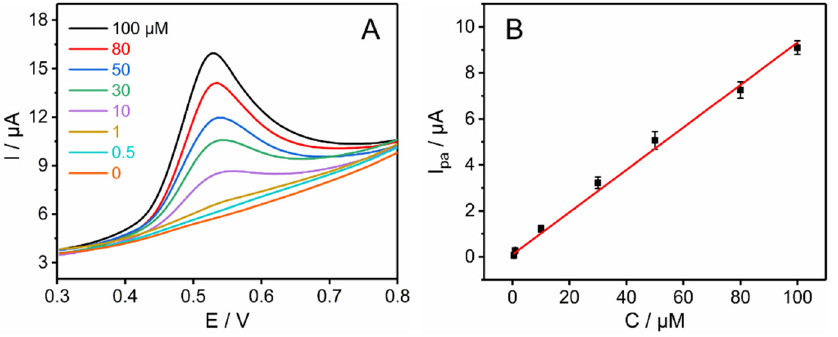
Figure 6. ( A ) DPV responses of the ZnO/BC sensor in different concentrations of BPA (50 mM PBS, pH 6.0). ( B ) Calibration curve for the determination of BPA (0–100 µ M). Table 1. Comparison with some previous sensors for BPA detection.